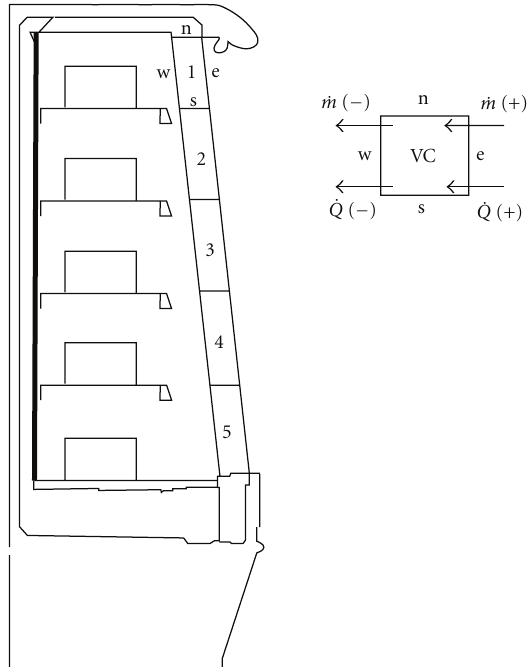
Figure 10: Subdivision of air curtain region by control volumes and sign convention of variables.